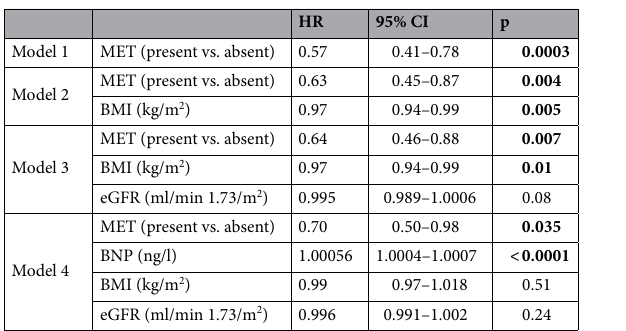
Table 2. Metformin and outcome, Cox proportional hazard analysis. MET treatment was associated with lower risk of an adverse outcome even after the adjustment for BNP, eGFR and BMI. HR hazard ratio, CI confidence interval. Significant values are in